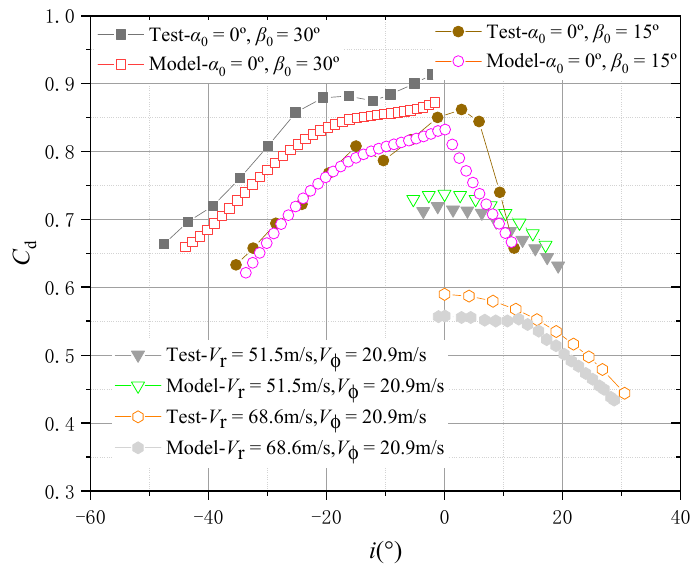
Figure 31. Comparison between the model prediction and the experimental data from the litera- ture.